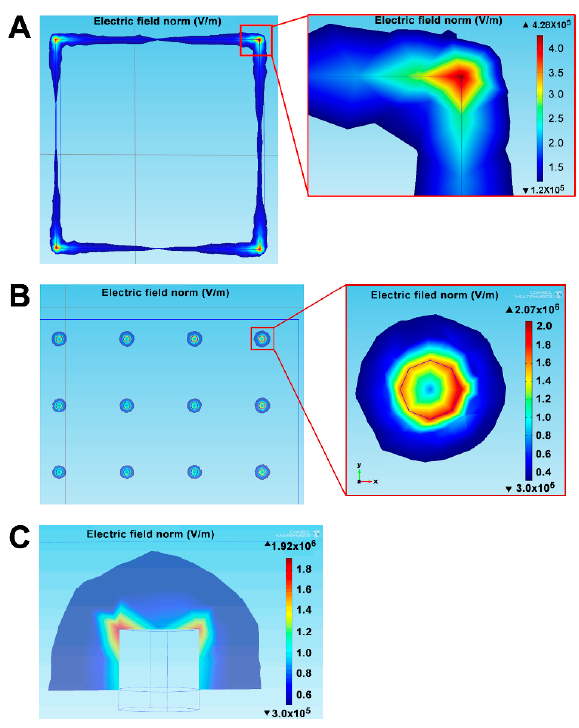
Figure 3. Simulation of electric field distribution of three different of electrodes. ( A ) Electric field distribution of the 7.4 × 7.4 µ m 2 microelectrode; (inset) the enlarged image of the electric field distribution at the corner of microelectrode. ( B ) Electric field distribution of 3D-NEA with a radius of 0.1 µ m and a height of 0.1 µ m; (inset) the electric field distribution for a single nano-electrode with a radius of 0.1 µ m. ( C ) The cross-section view of the electric field distribution for the 3D nano-electrode with a radius of 0.1 µ m. These data were simulated by the COMSOL Multiphysics software